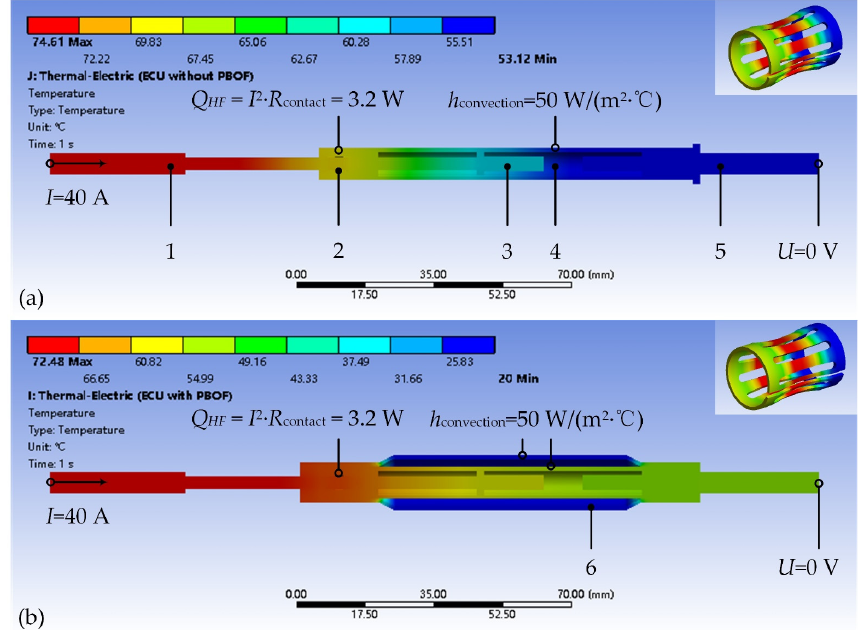
Figure 7. The temperature distribution of the electric contact with ( a ) PBOF technology and ( b ) dual- bladder PBOF technology: 1-contact pin; 2-electric socket; 3-moveable stopper; 4-conductive sleeve; 5-conductive shaft; 6-secondary resilient bladder.